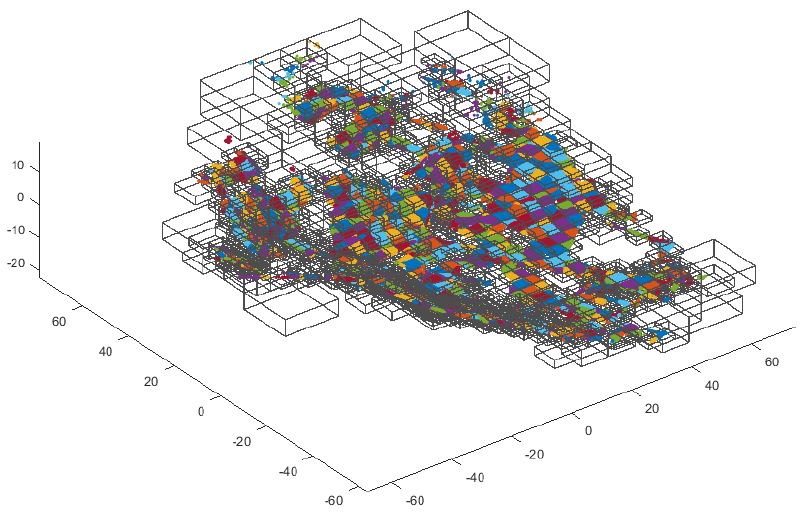
Figure 3. Demonstration of the non-uniform spatial distribution of keypoints (( a – d ) are the detected keypoints by 3DSIFT detector).